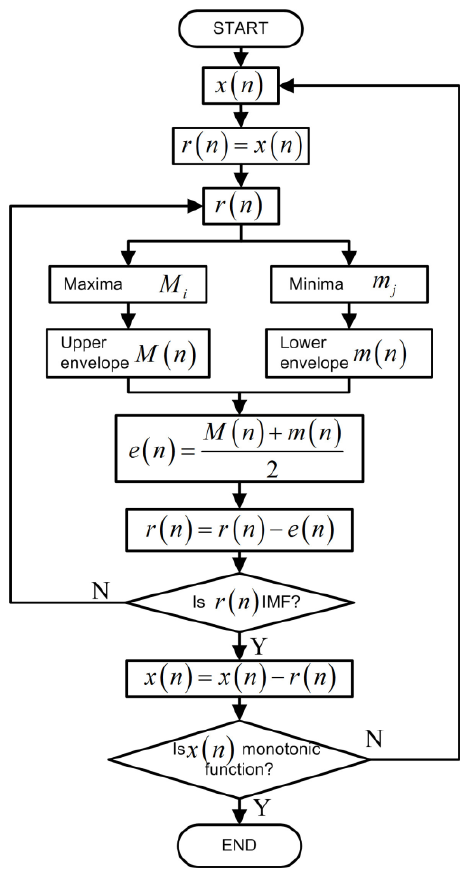
Figure 1. Main process of sifting algorithm of EMD. The procedure stops if the final residual is a monotonic function. The result is a set of IMFs and the residual.